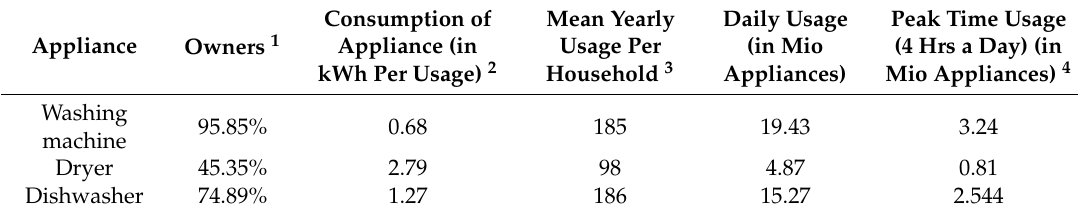
Table 7. Data used to estimate shifts in electricity demand.